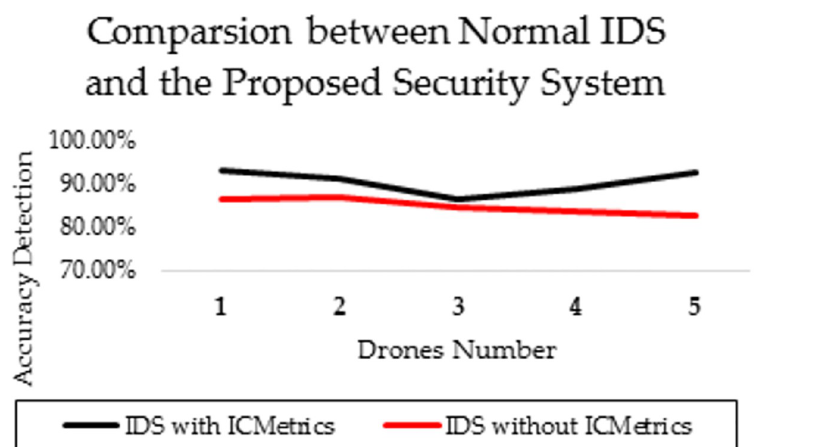
Fig 13. Comparison between the proposed system and other IDS